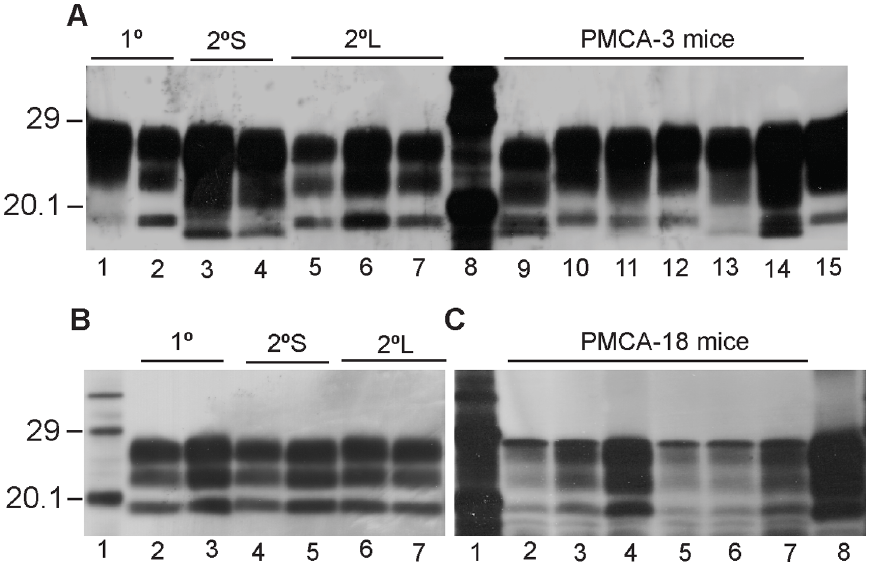
Figure 6. Western blot of PrP Sc from tg338 mice challenged with PMCA products. Inoculum-3 1 u , 2 u S and 2 u L mice are shown in lanes 1– 7:1 u , lanes 1 and 2; 2 u S, lanes 3 and 4; 2 u L, lanes 5 to 7. Lanes 9–14 show mice inoculated with PMCA-3. Lane 15 is loaded with PMCA product prior to inoculation. (b) Inoculum-18 1 u , 2 u S and 2 u L mice are shown: 1 u , lanes 2 and 3; 2 u S, lanes 4 and 5; 2 u L, lanes 6 and 7. (c) Mice inoculated with the PMCA-18 are shown in lanes 2–7. Lane 8 is loaded with PMCA product prior to inoculation. Samples were further diluted in Laemmli sample buffer to achieve visible molecular weight profiles. Remaining lanes show molecular mass markers.